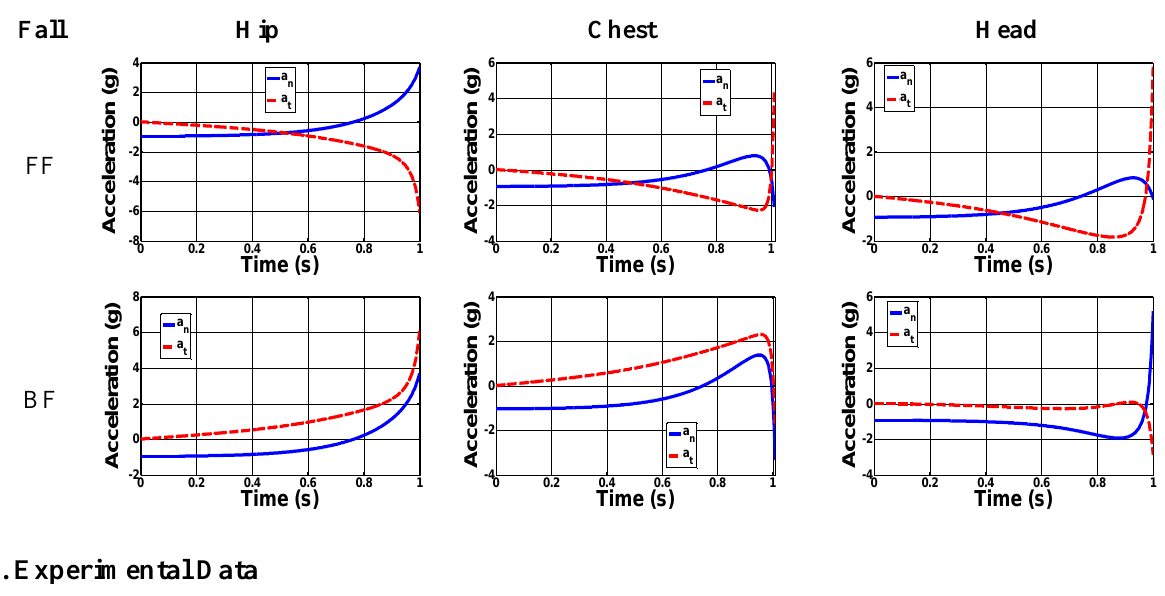
Figure 3. Forward Fall (FF) and Backward Fall (BF) accelerations for the hip, chest and head